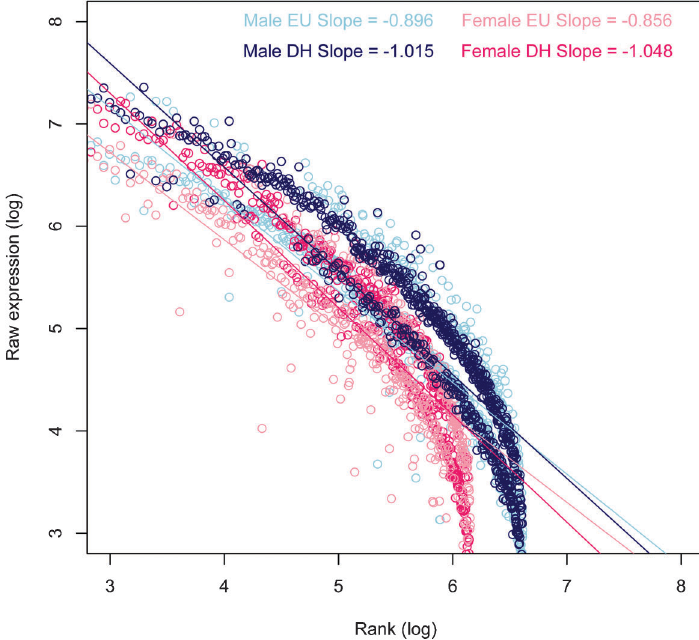
Figure 2. The list of probes used to construct the log rank-log expression was attenuated to only include those probes that were significantly regu- lated by dehydration. The slope is closer to